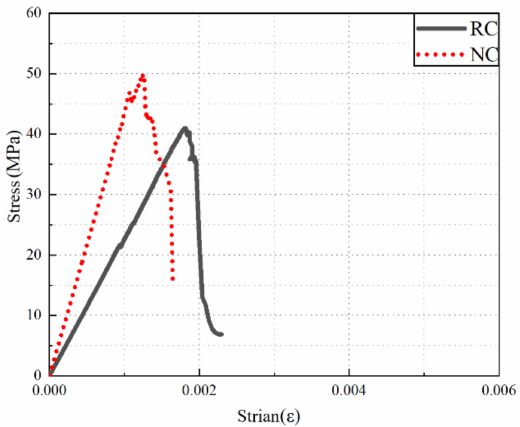
Figure 12. Uniaxial compression stress-strain curve of recycled concrete and natural concrete. The uniaxial stress–strain curve for single admixture fibre recycled concrete is shown in Figure 13. The uniaxial compressive strength of SF recycled concrete increased with the increase in fibre admixture and increased by up to 14.2% compared with that of non-fibre recycled concrete. The softening branch tends to flatten out. The main reason is that the steel fibre volume amount increased. On the one hand, the number of steel fibre involved in restraining concrete cracking increased, while, on the other hand, steel fibre absorbed more of the concrete’s compression deformation energy, which was converted into their own tensile deformation energy. So, the softening branch of the uniaxial stress–strain curve for recycled concrete became smoother, as shown in Figure 13a.